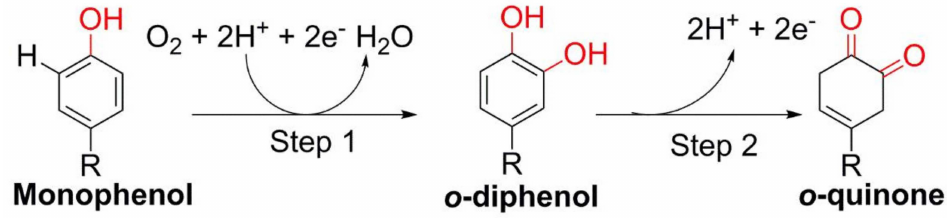
Figure 3. The reaction catalyzed by tyrosinase. Adapted with permission from Ref. [55]., 2018, Lai et